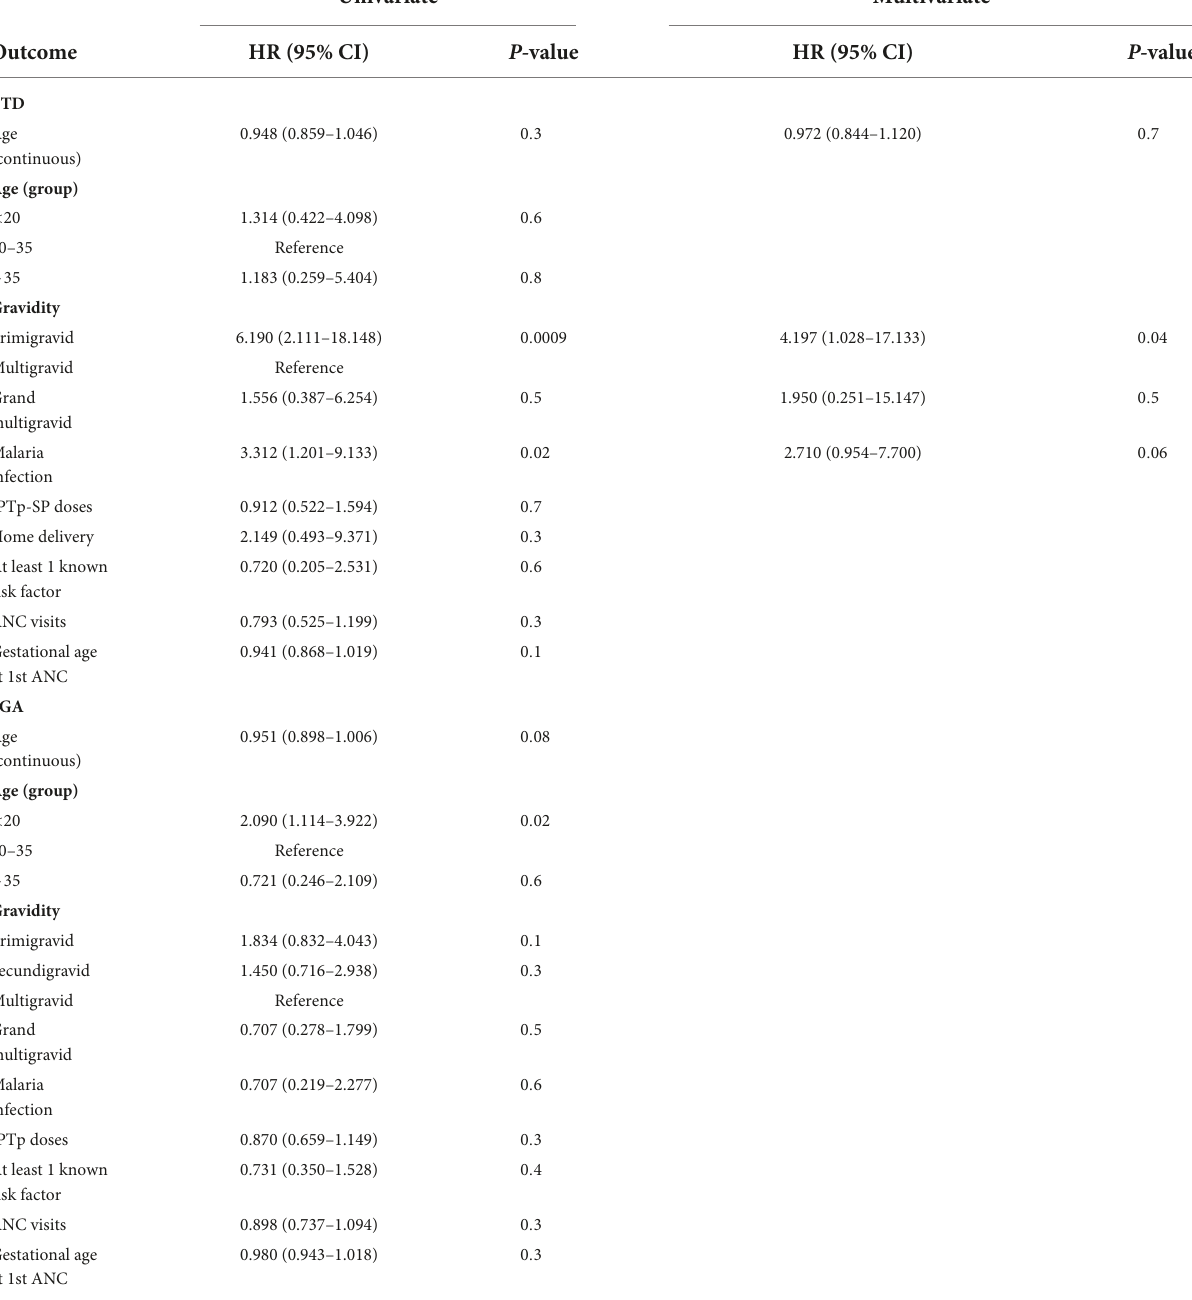
TABLE 5 Risks associated with preterm delivery and small for gestational age. Univariate